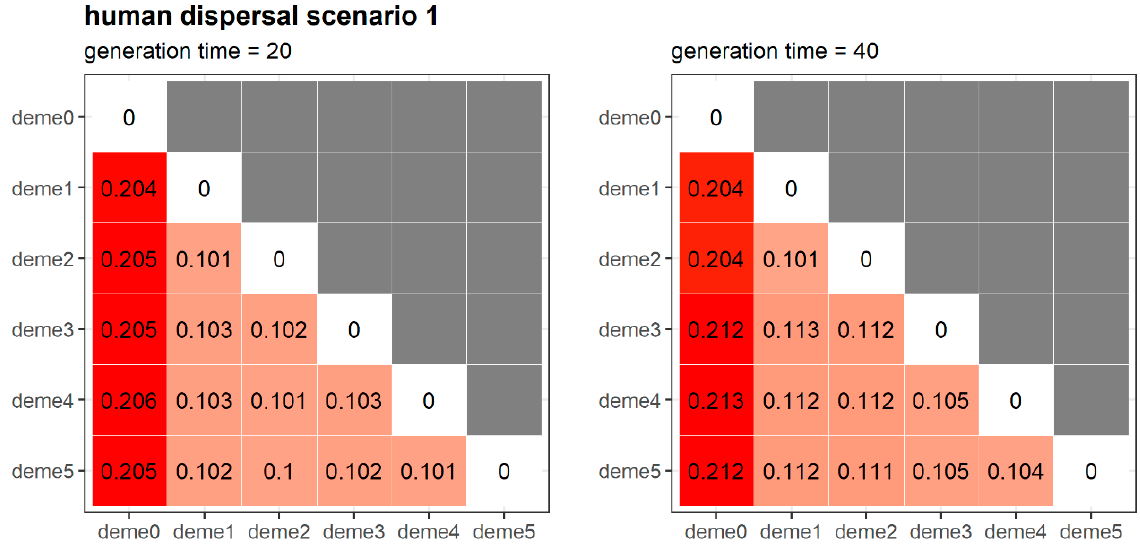
Figure A3. The mean pairwise Fst values calculated across 100 replicate simulations of a post- megafauna dispersal scenario (“nd” in Table A1). This dispersal scenario assumes that there has been no migration for 60,000 years (3500 or 1750 generations).